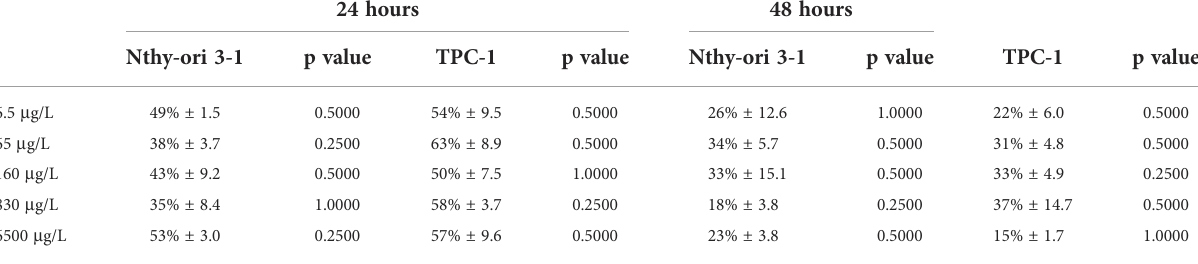
TABLE 1 Percent mortality of Nthy-ori 3-1 and TPC-1 cells after exposure to Roundup ® Original DI for 24 h and 48 h at different concentrations, measured by Trypan Blue exclusion test.